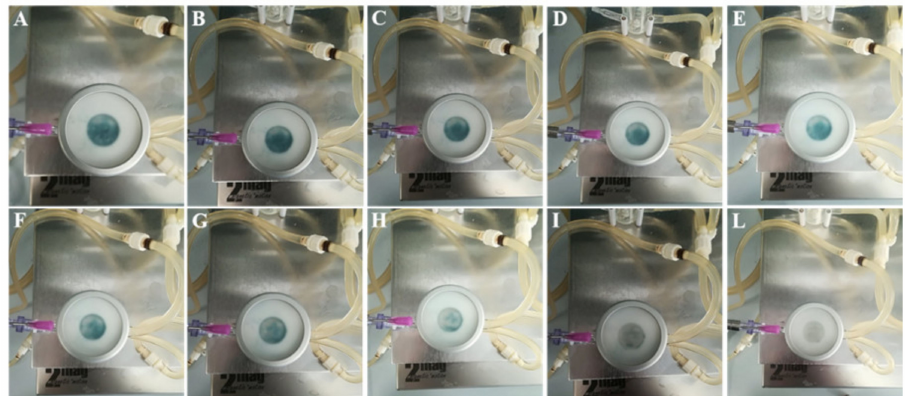
Figure 8. Permeation study–Pictures at di ff erent time points, ( A ) 0 min; ( B ) 10 min; ( C ) 20 min; ( D ) 40 min; ( E ) 60 min; ( F ) 90 min; ( G ) 120 min; ( H ) 150 min; ( I ) 210 min; ( L ) 360 min, after CM-HSE application in donor compartment of the Franz cell apparatus.